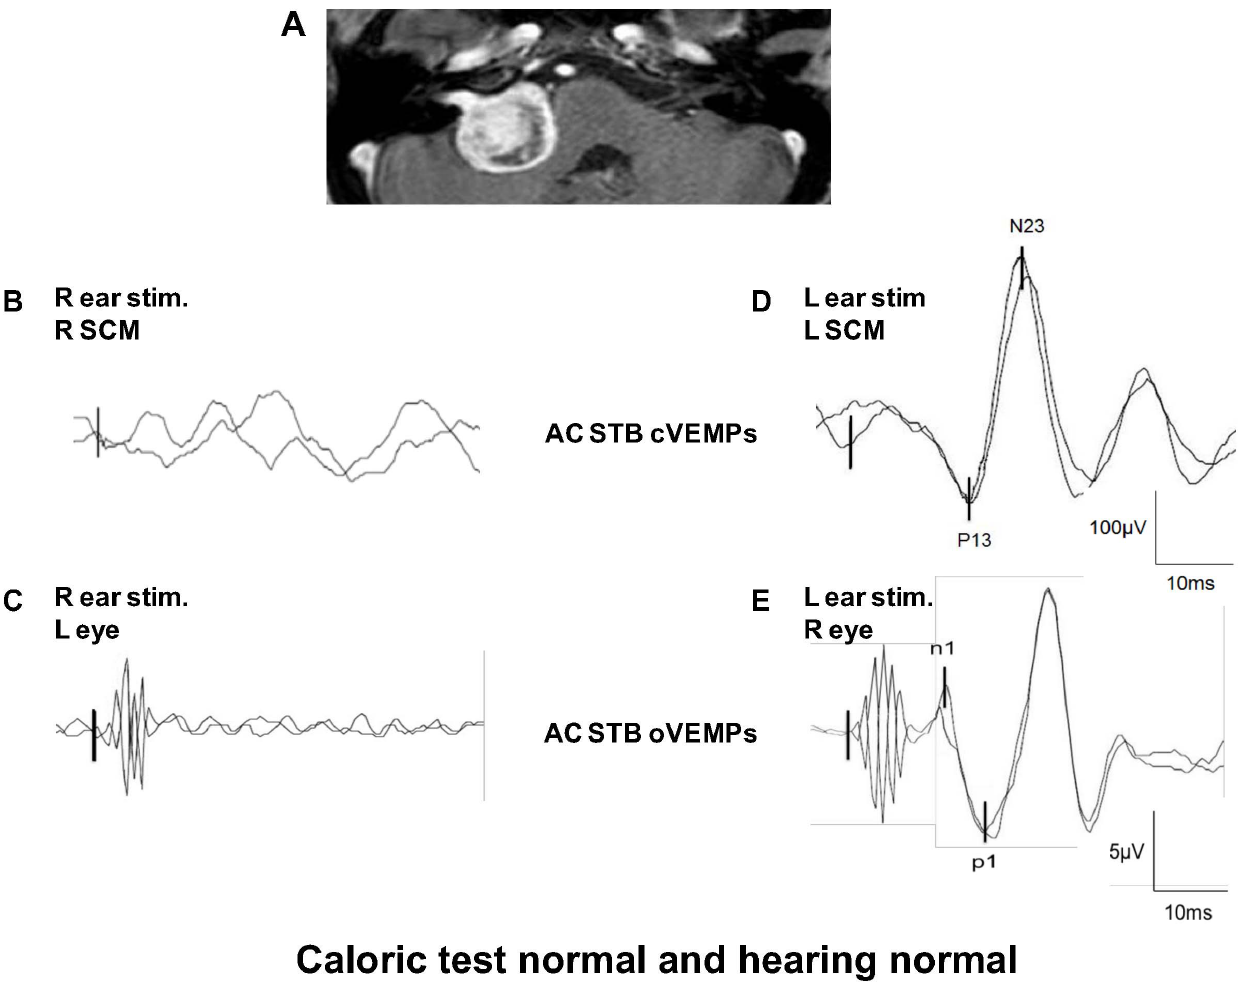
Figure 2. Clinical utility of VEMP test in vestibular schwannoma patients. This patient has a right VS in the cerebello-pontine angle. Despite the size of the VS (MRI in A ), he had both normal hearing and caloric test results. Patient had superior nerve dysfunction (absence of AC STB cVEMP on the right SCM when the right ear was stimulated: B ) and inferior nerve dysfunction (abnormal AC STB oVEMPs on the left eye when the right ear was stimulated: C ). When the left intact ear was stimulated, normal AC STB cVEMPs ( D) and normal AC STB oVEMPs ( E ) were